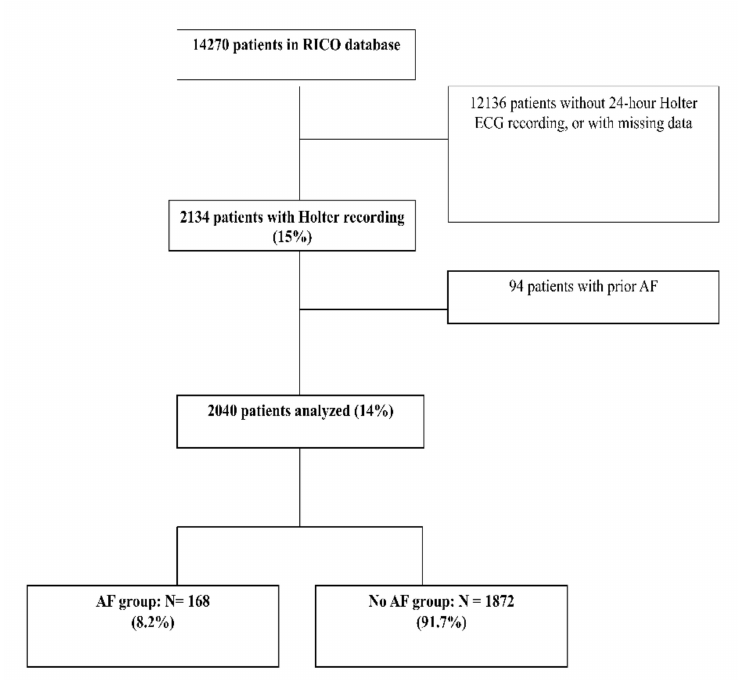
Figure 1. Study Flow